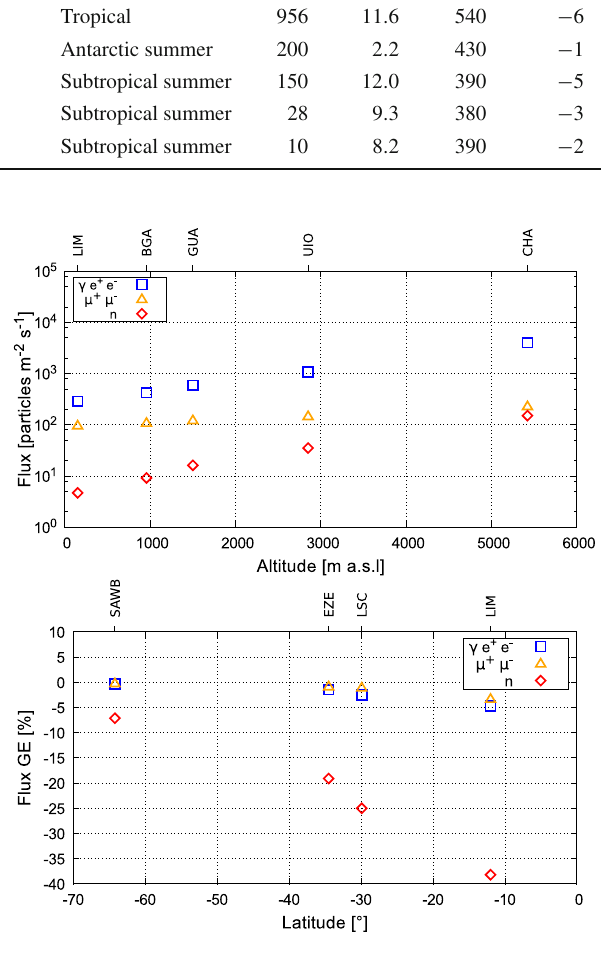
Fig. 4 The flux ( Ξ ) of cosmic background radiation at the ground as a function of the altitude at five LAGO sites with very different altitudes but similar geomagnetic rigidities are shown in the upper panel for different components of the cascades: the electromagnetic component in blue squares ( γ , e − , e + ), the muonic component in yellow triangles ( μ − , μ + ) and neutrons as part of the hadronic component are shown in reddiamonds( n ).Thealtitudeeffectonthefluxisvisible.Instead,inthe lower panel, the same flux is shown as a function of the geomagnetic rigidity for four LAGO sites with similar altitudes but very different values of the local rigidity cut-offs R c . While the effect on the total flux is not as significant as the altitude effect, the impact of the latitude on the neutron flux is quite